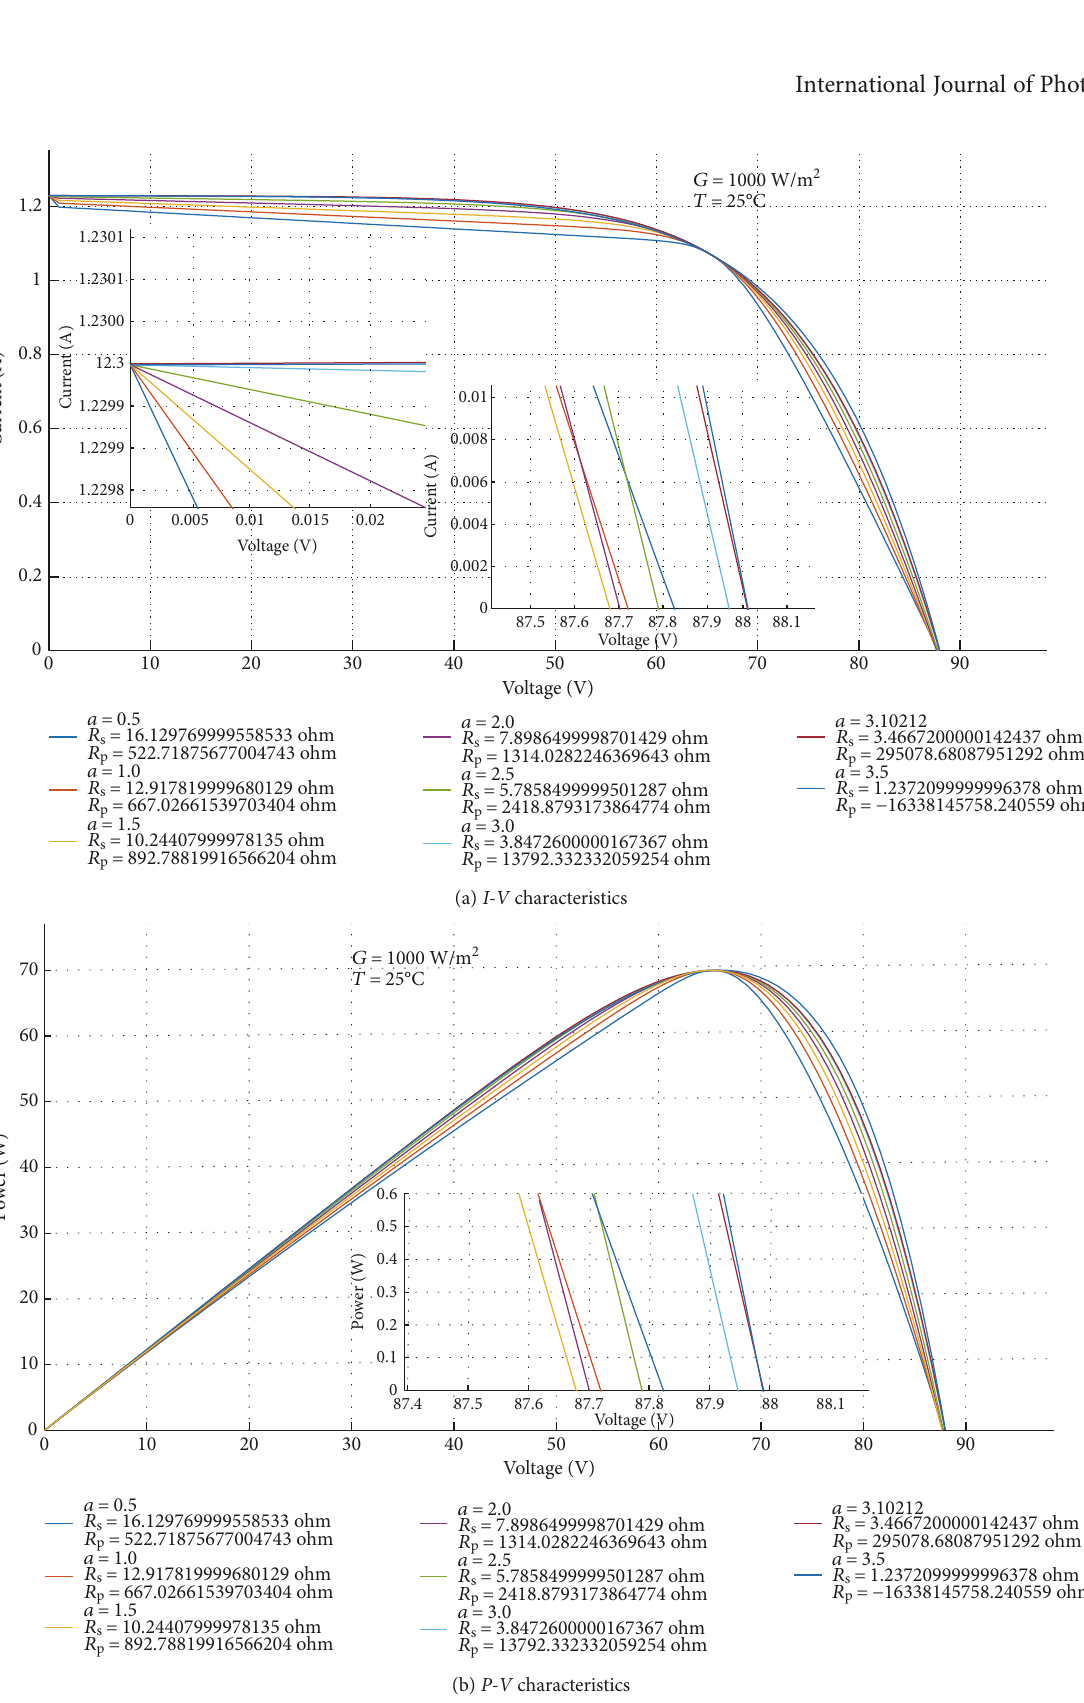
Figure 3: Characteristics for eight values of a 1000W/m 2